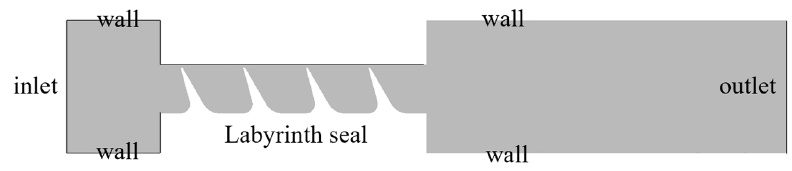
Figure 5. The computational domain and boundaries.